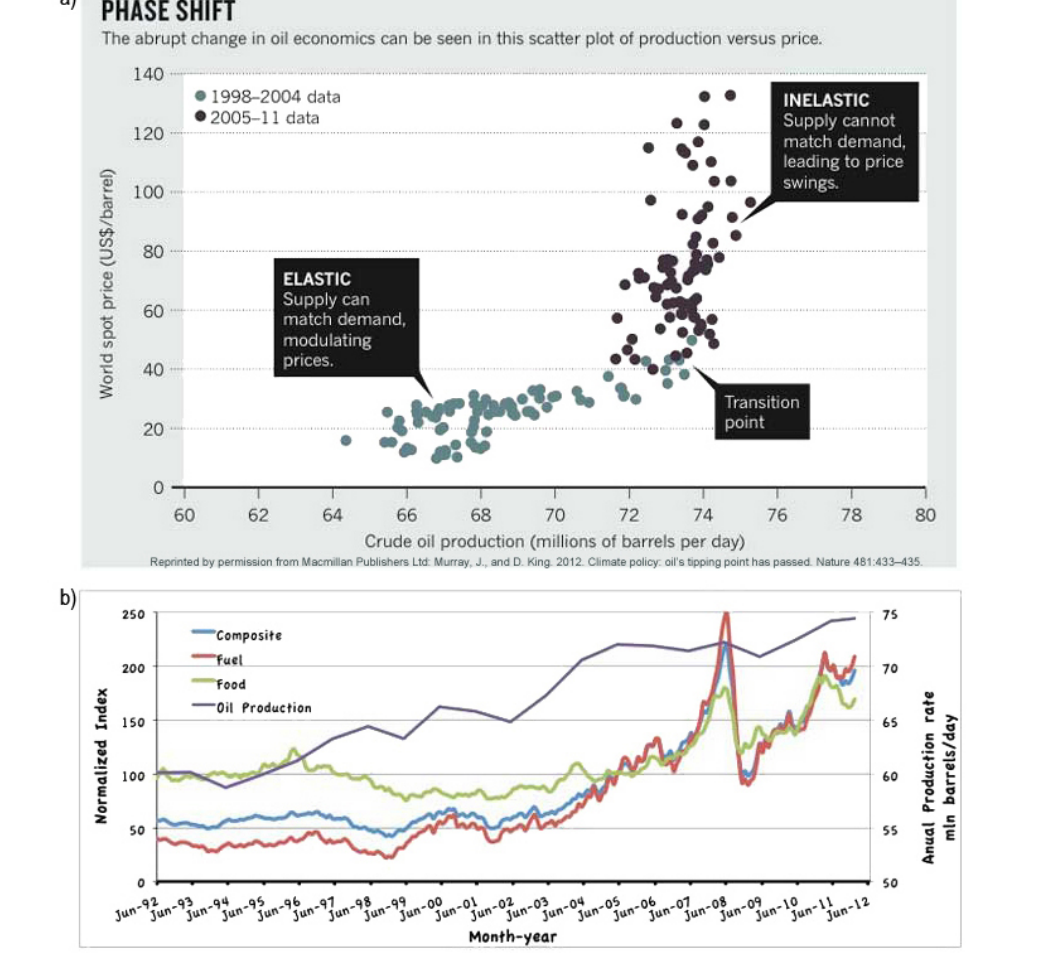
Fig. 3. . (a) A scatter plot showing a distinct change in the relationship between oil production and oil prices over the last 12 years, from Murray and King (2012). This is interpreted as an indicator that, after 2005, production was no longer able to match rising demand, which is reflected by higher and more variable prices. (b) A 20-yr time series of the annual oil production, purple line – right axis, from (http://www.indexmundi.com). The rest of the plots are commodity indexes for